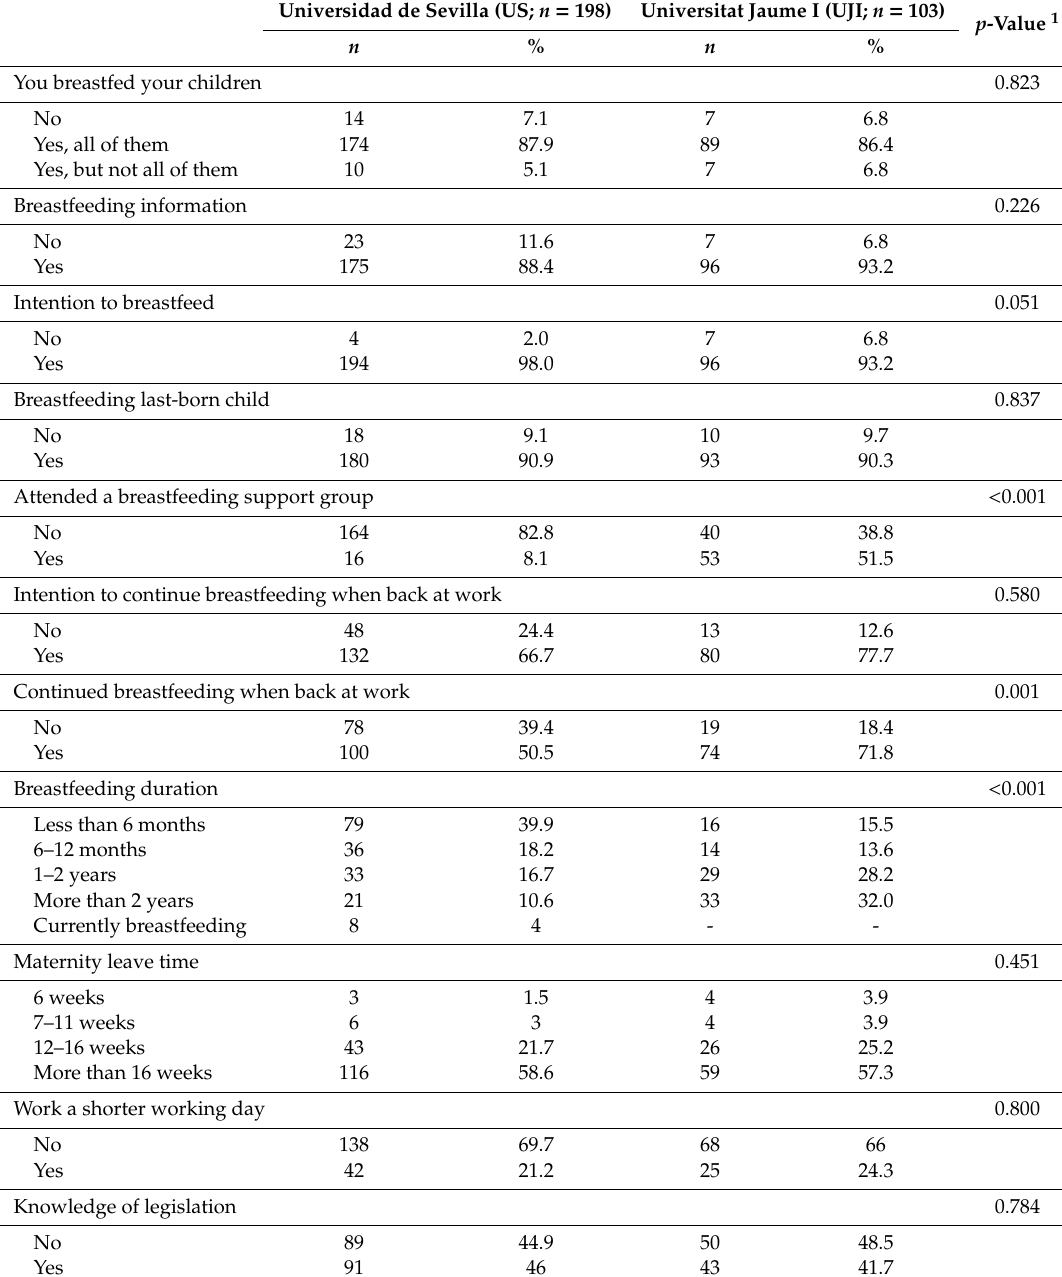
Table 2. Data on breastfeeding and family–work conciliation measures ( n =